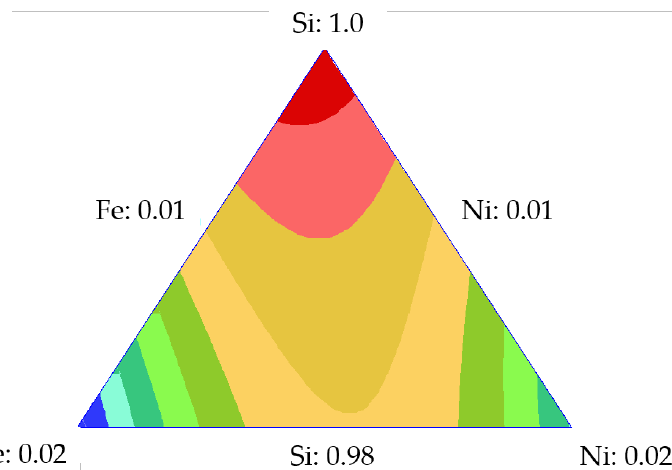
Figure 7. Response surface of the amount of adsorbed asphaltene for the Si-Fe-Ni mixture design at a concentration of 100 mg · L − 1 .